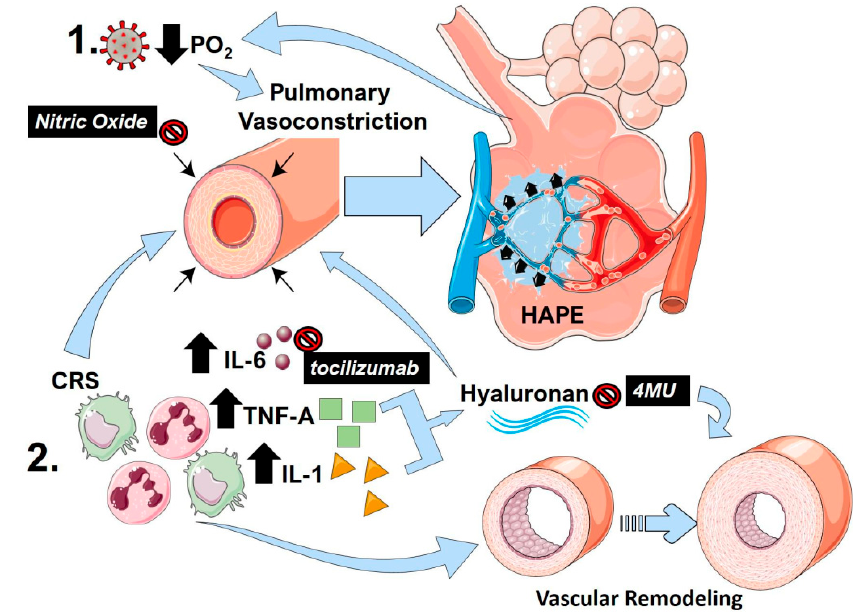
Figure 2. The link between pulmonary vasoconstriction, high altitude-induced pulmonary edema (HAPE) and the cytokine release storm (CRS) in COVID-19. (1) Following SARS-Cov-2 infection, reduced PO 2 and resulting hypoxia can promote sustained pulmonary vasoconstriction, resulting in pulmonary edema akin to HAPE. This in turn results in reduced PO 2 that can itself further promote vasoconstriction, resulting in a vicious circle. (2) The cytokine release storm (CRS) in COVID-19 results in an increased in inflammatory cytokines including interleukin (IL)-1 (yellow triangles) IL-6 (brown circles) and tumor-necrosis factor alpha (TNF-A green squares). IL-6 and TNF-A are capable of promoting pulmonary vasoconstriction and vascular remodeling, which are important hallmarks of PH. TNF-A and IL-1 can promote increased hyaluronan levels that also stimulate vascular remodeling and pulmonary vasoconstriction. Clinically tested agents are shown in black boxes with white font. Nitric oxide can promote vasodilation reversing pulmonary vasoconstriction. Tocilizumab is a monoclonal antibody against IL-6, and 4-methylumbelliferone (4MU) inhibits hyaluronan synthesis.